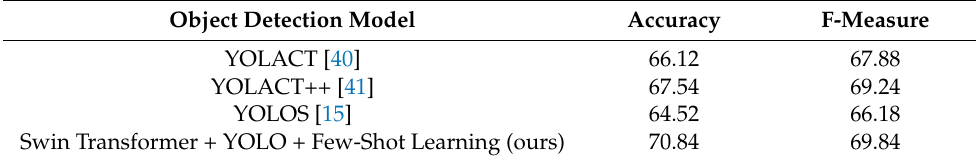
Table 3. The performance evaluation results based on the confusion matrix.